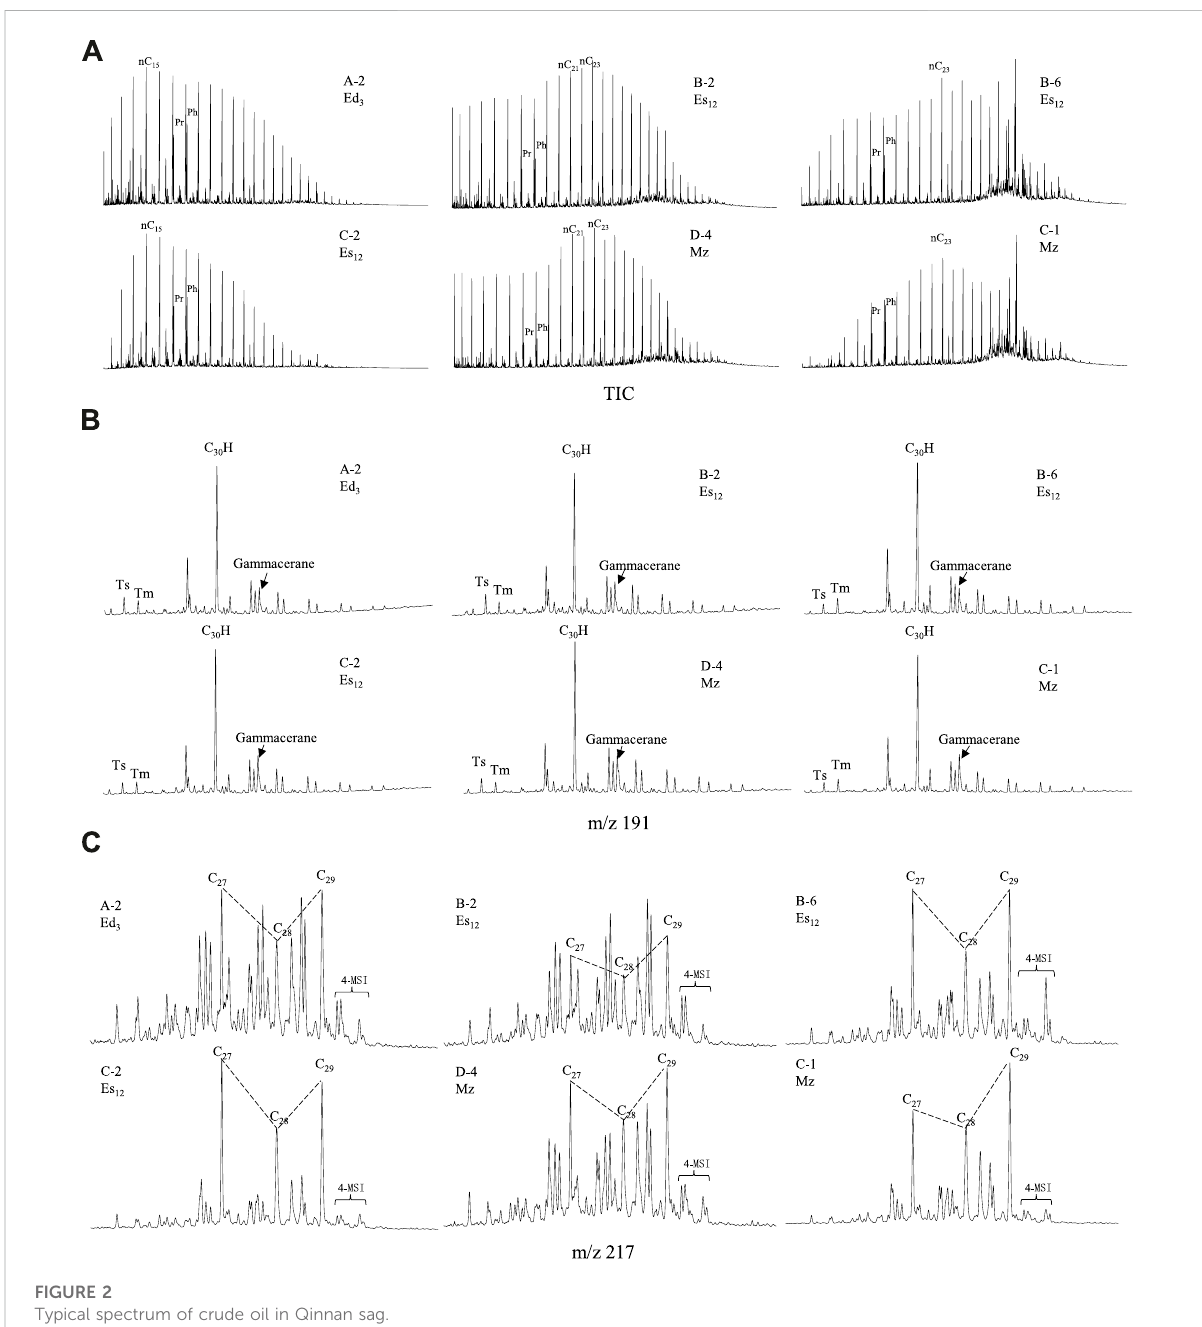
FIGURE 2 Typical spectrum of crude oil in Qinnan